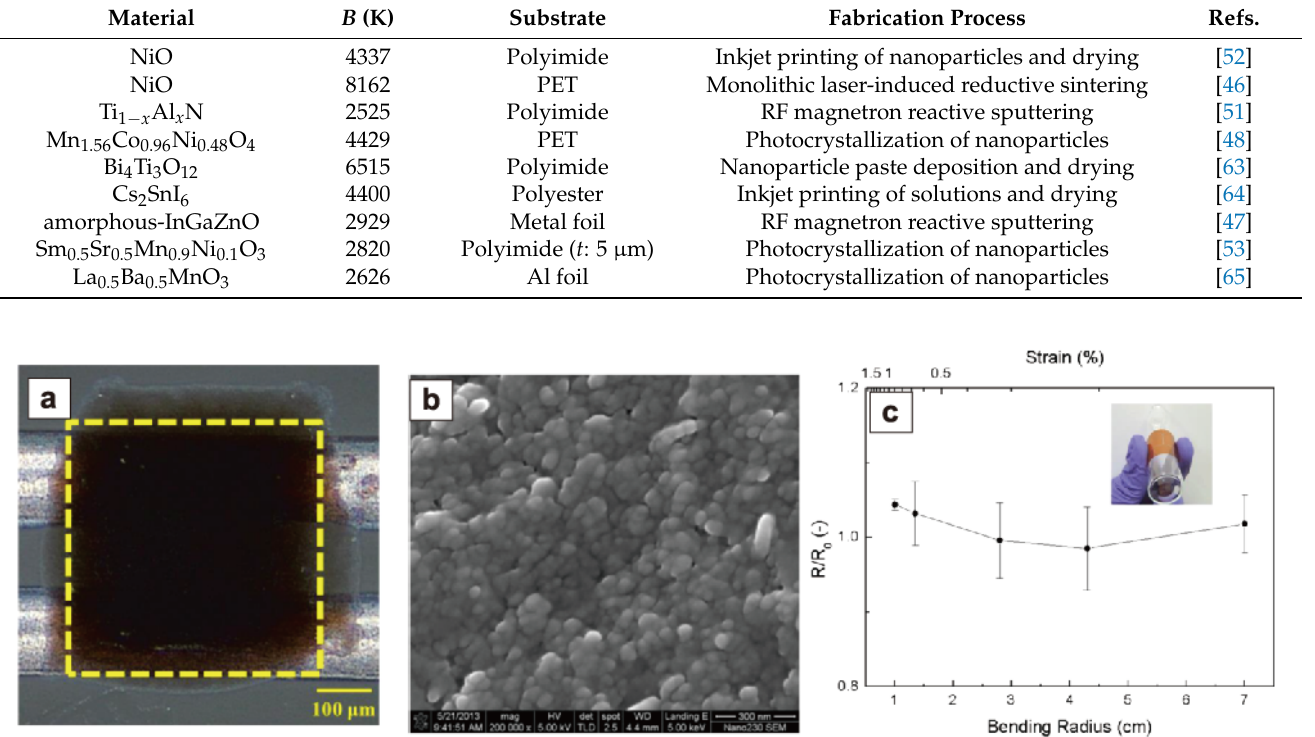
Figure 3. ( a ) Printed NiO film over silver tracks on a glass plate at 25 °C. ( b ) The SEM image of the NiO thin film. ( c ) Electrical resistance variation with the bending radius for printed thermistors on a polyimide film at 50 ◦ C. Reprinted with permission from Ref. [52]. Copyright 2013 American Chemical